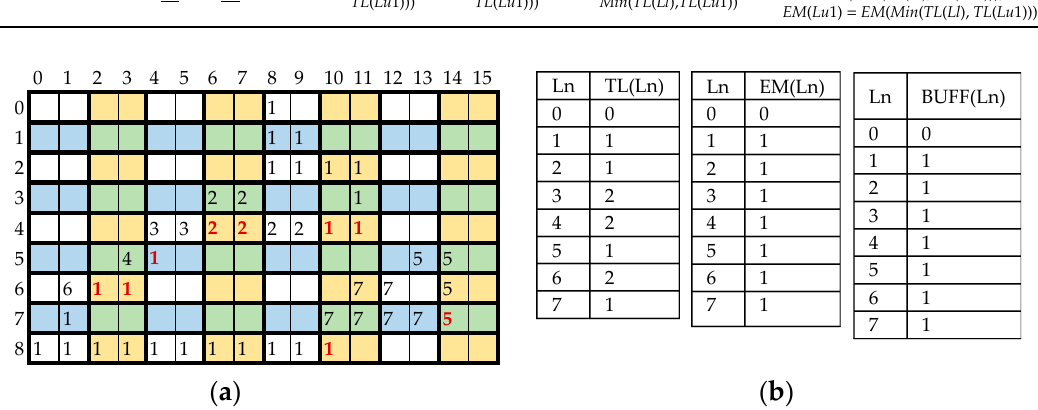
Figure 7. Example of parallel CCL: ( a ) the provisionally labeled image; ( b ) content of TL, EM, and BUFF.